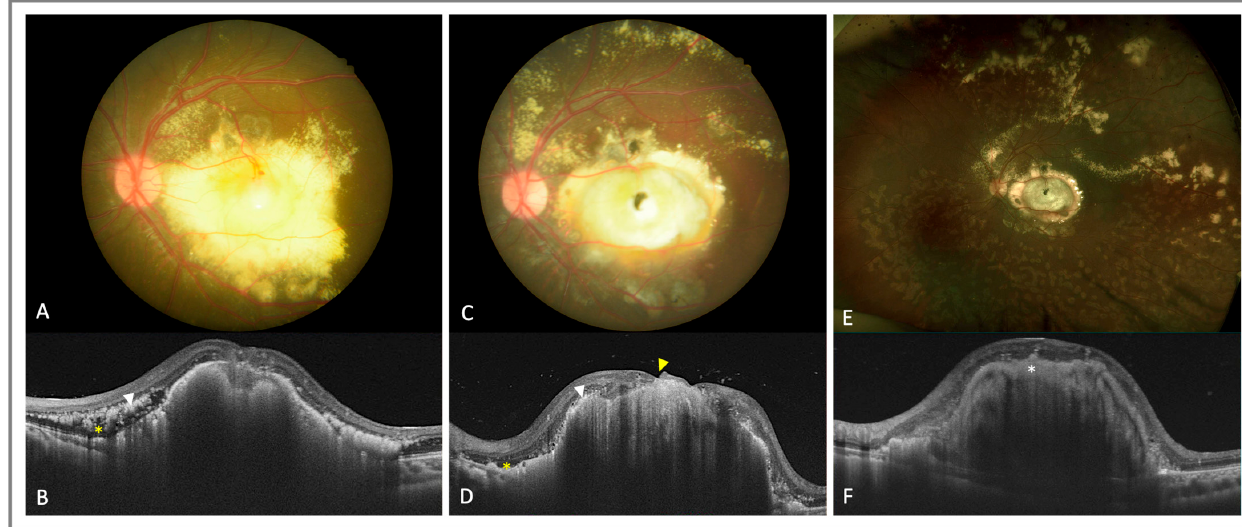
Figure 3. OCT images showing Coats disease. A 7-year-old boy presented with Coats disease in the left eye with a BCVA of 0.06. ( A ) Color fundus photography showing a massive macular exudation and telangiectatic vessels. ( B ) OCT image showing subretinal fluid (yellow asterisk) and intra-retinal hyper-reflective materials (white arrow) corresponding to exudates. ( C ) One year after multiple sessions of intravitreal bevacizumab and laser photocoagulation treatment, the exudation partially resolved and became more consolidated with a macular scar formation. ( D ) OCT image showing the submacular exudation breaks through the internal limiting membrane, with a reduction in subretinal fluid and hyper-reflective materials (white arrow). ( E ) Two years after treatment, the macular scar became more well-defined and the mid-peripheral laser scars were visible on ultra-widefield imaging. ( F ) The corresponding OCT image showing subretinal fibrosis and organization (white asterisk) with the resolution of subretinal fluid, intra-retinal cysts and hyper-reflective dots, which indicates reduced activity.